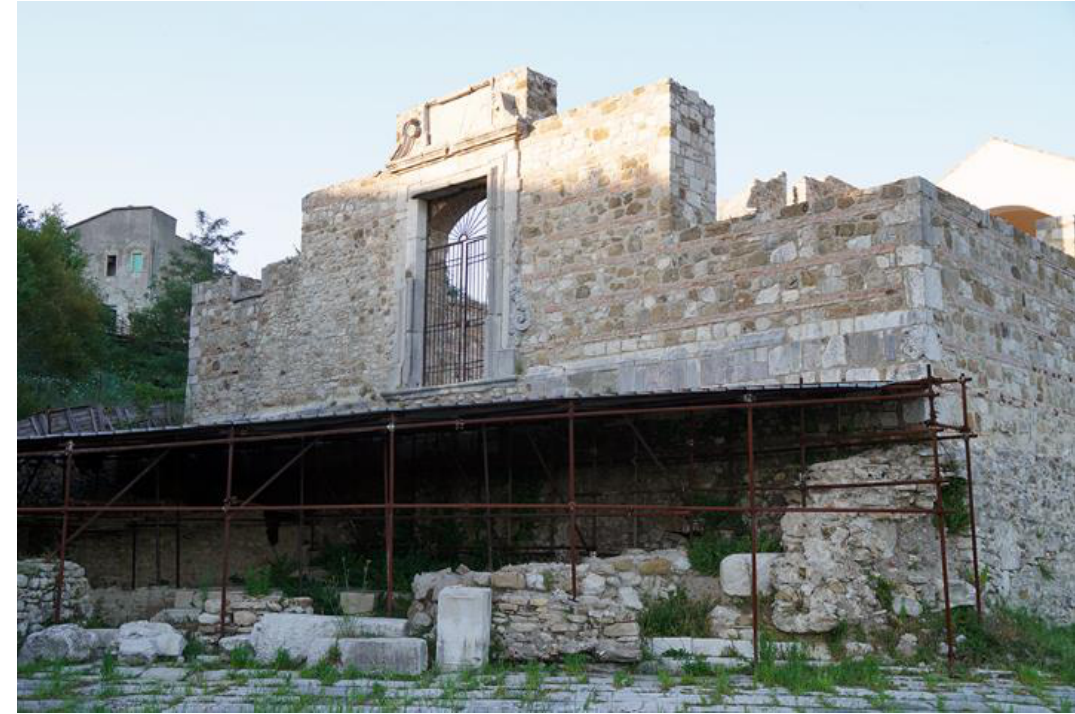
Figure 14. Conza della Campania: old village with the Archaeological Park realized a few years ago for the tourists (photos by [35,36]).